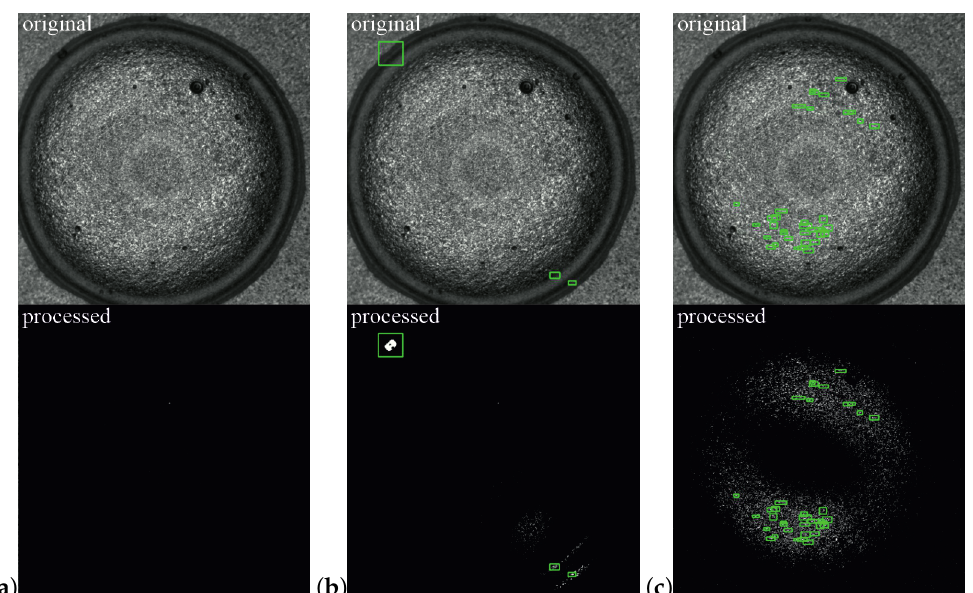
Figure 7. Example of results of the video processing algorithm. The upper part of the images represents the originally captured frames and the lower part, the processed frames. ( a ) Bubbles in the droplet can be seen in the original frame but the algorithm detected no activity, ( b ) shows the subsequent frame. The bubble on the upper-left edge of the droplet has burst, which was detected by the algorithm and is highlighted with a green rectangle. ( c ) Small vibrations in the test setup caused 37 detections at once; such disturbances were not considered in the subsequent analysis.